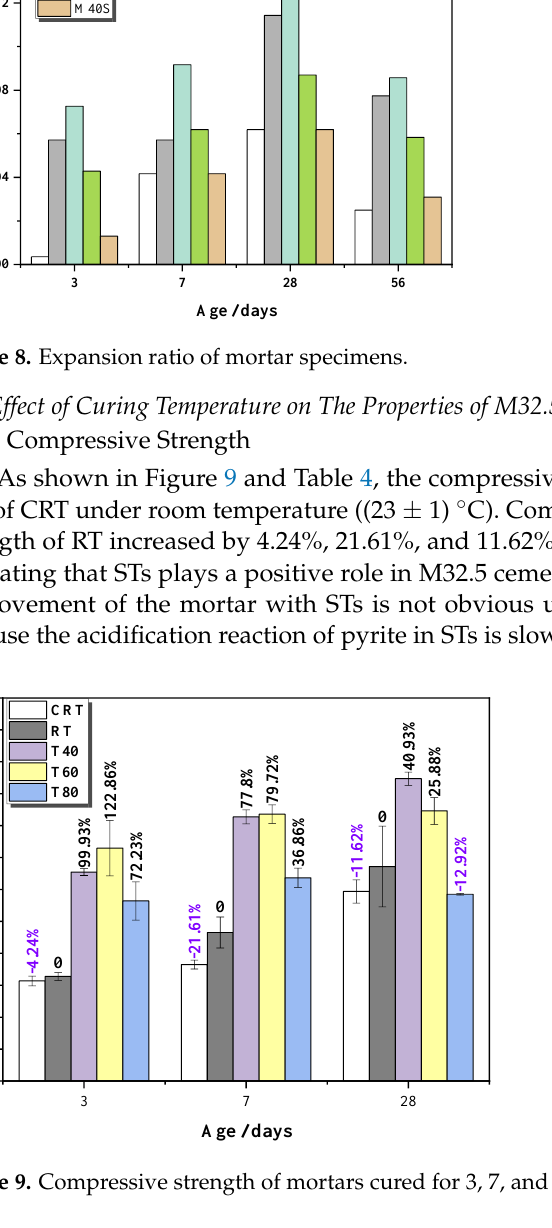
Figure 8. Expansion ratio of mortar specimens.